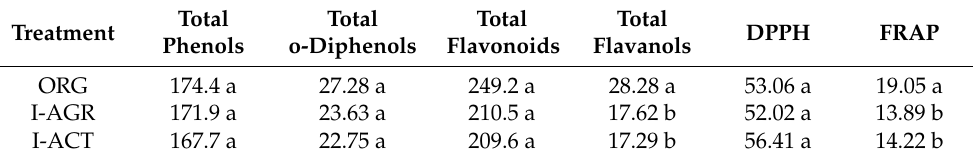
Table 4. Effects of cultivation management on fruit total phenol (mg gallic acid equiv. 100 g − 1 F.W.), total